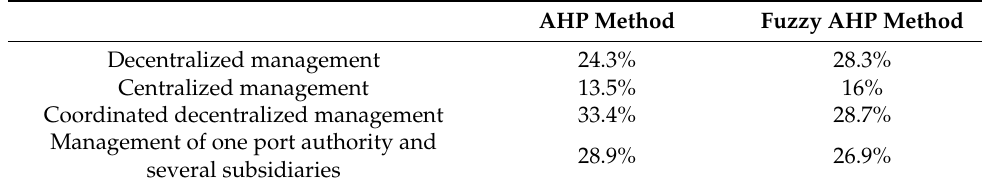
Table 6. Comparison of the evaluated